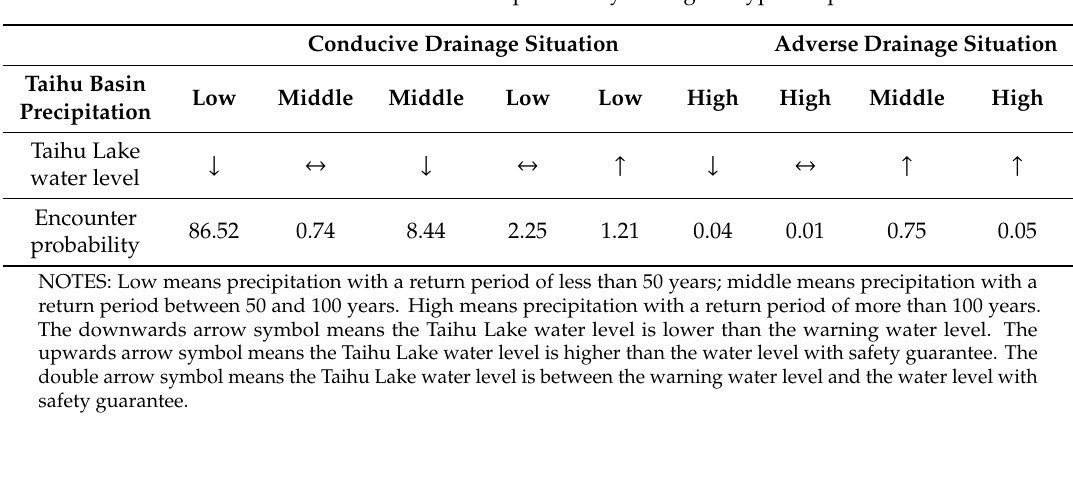
Table 8. Calculation of encounter probability during the typhoon